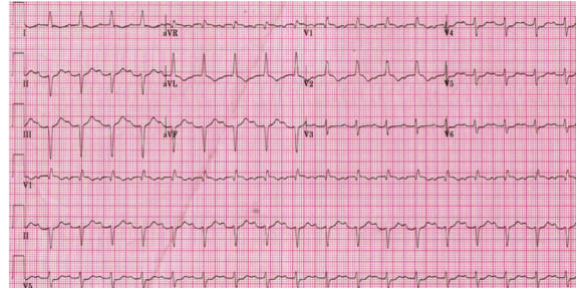
Figure 1: ECG on presentation (case one). Showing sinus tachycar- dia, left axis deviation, and T-wave changes.